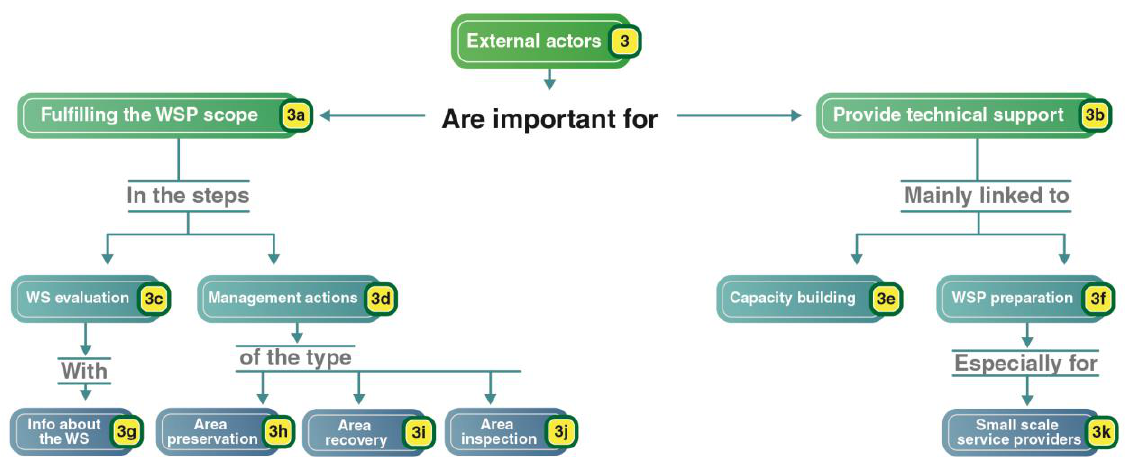
Figure 7. Acting field of external actors to the water supply public service providers which impact the WSP implementation (drafted by the author). WS = watershed; WSP = water safety plan.